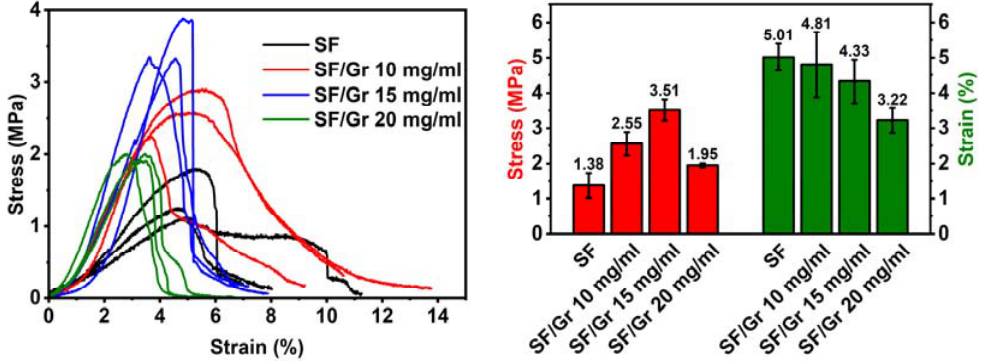
Figure 5. The mechanical properties of nanofiber membranes.